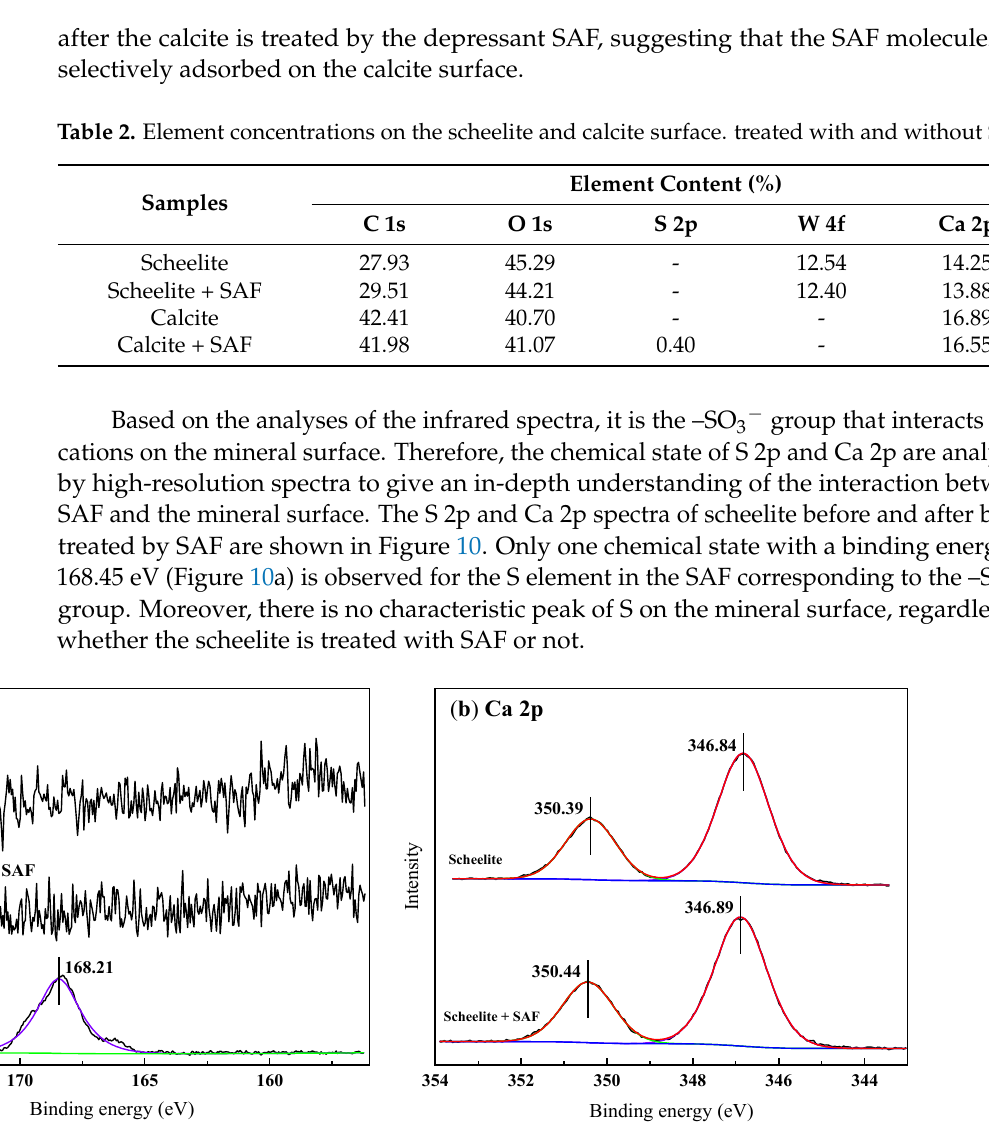
Figure 10. XPS of ( a ) S 2p and ( b ) Ca 2p signal of scheelite treated with and without SAF at pH 9. The spin-orbit splitting of Ca 2p peak (Ca 2p3/2 and Ca 2p1/2 components by about 3.55 eV, with an intensity ratio of 2:1) in pure CaWO 4 is observed in Figure 10b.